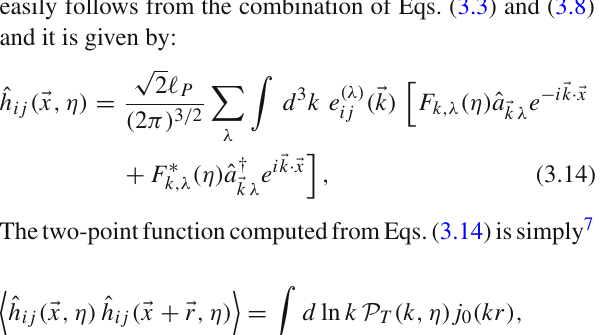
common logarithm of the propagating speed (coinciding, in our case, with the phase velocity) in natural units. On the horizontal axes of both plots the common logarithm of the scale factor is